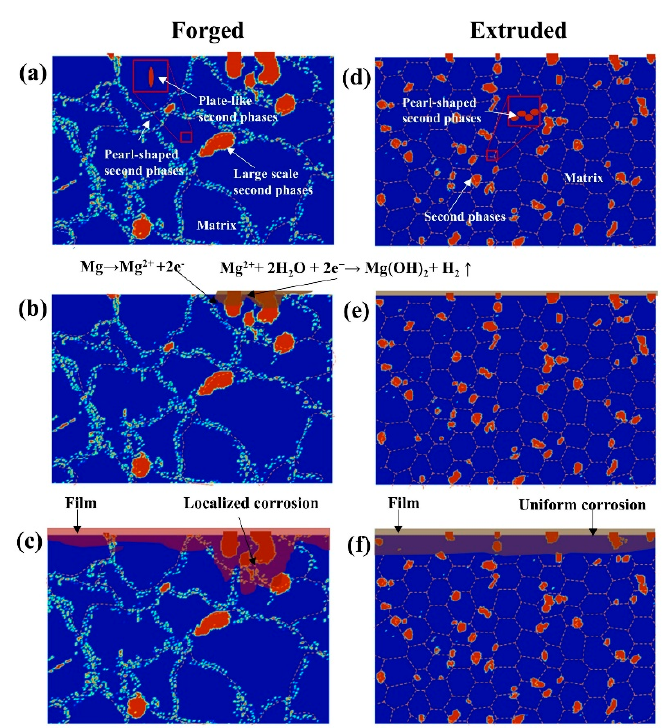
Figure 13. Schematic illustration of the development of surface film with increasing immersion